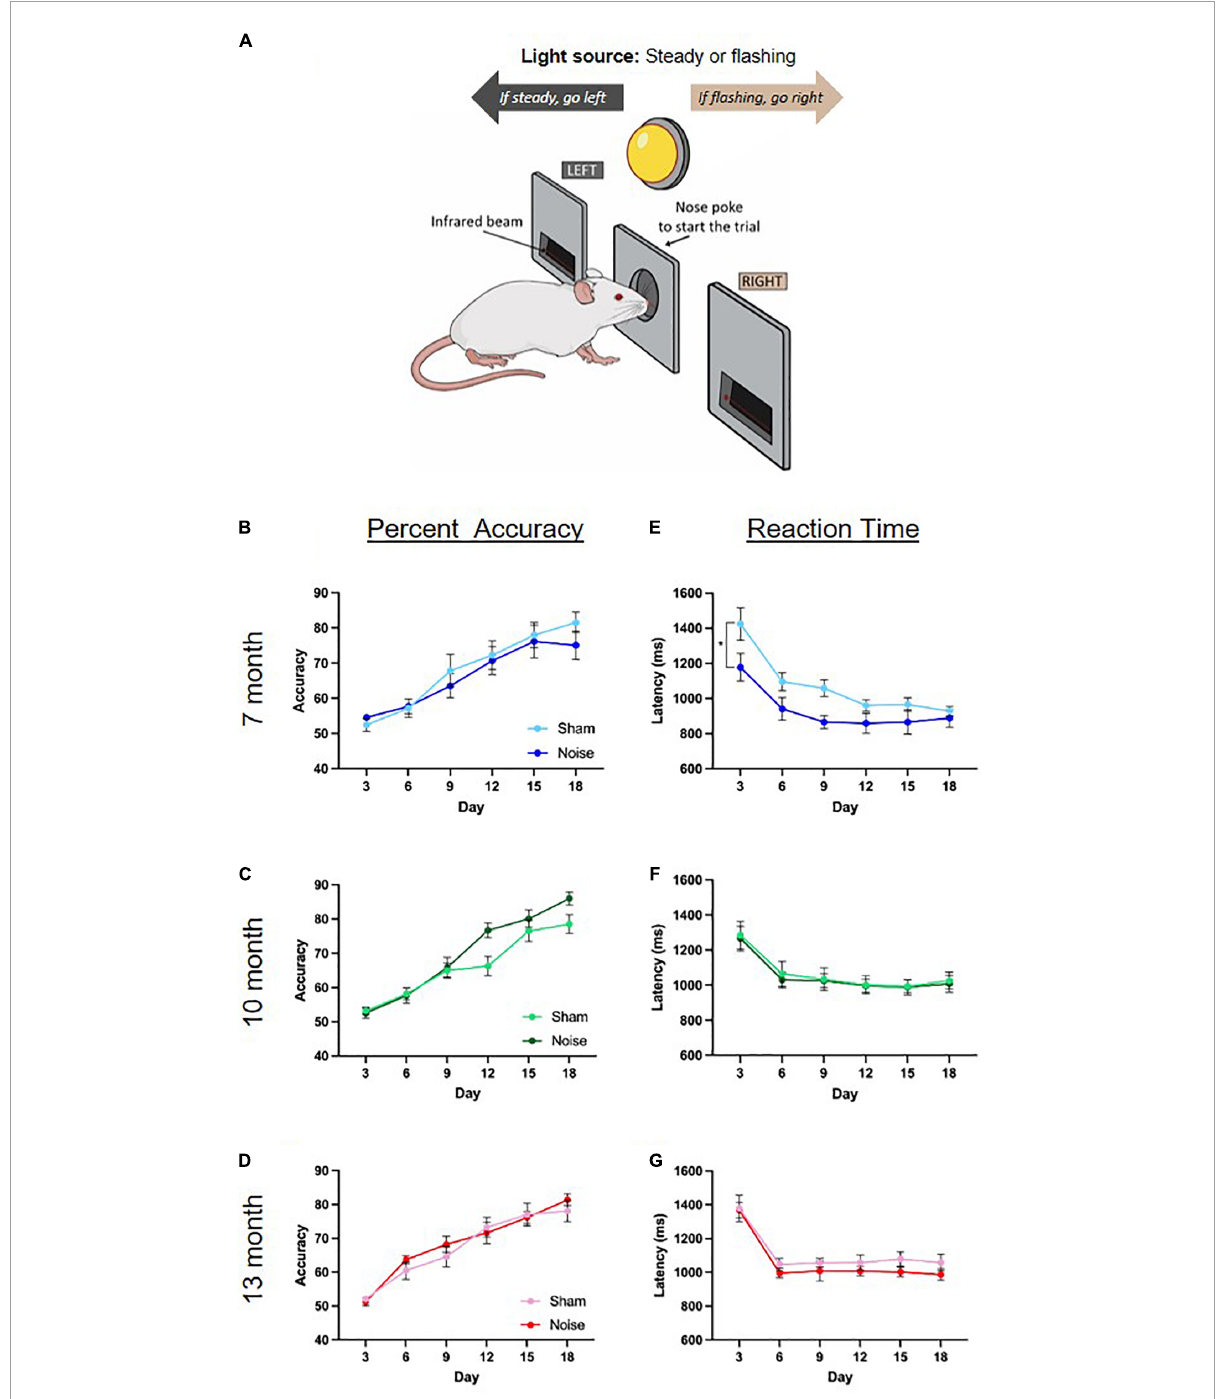
FIGURE4 Noise-exposed rats demonstrated no significant deficits in performance accuracy on the visuomotor associative learning task, but exhibited a faster reaction time in the month post-noise exposure. (A) Rats were trained on an operant conditioning-based visuomotor associative learning task. Following the initiation of a trial caused by a noise poke in the center port, rats learned to access the left feeder trough when the steady light stimulus was presented, and the right feeder trough when the flashing light stimulus was presented. (B–D) Rats at each age demonstrated learning over the 18 days of the task, with no significant differences in percent accuracy between noise- or sham-exposed rats at any age. (E–G) Noise-exposed rats at 7 months of age showed a significantly faster reaction time than their sham-exposed counterparts, an effect that did not persist at 10 or 13 months of age (significant main effect of treatment, * p < 0.05). n = 7-month (Sham: 9 male; Noise: 9 male), 10-month (Sham: 9 male; Noise: 9 male), and 13-month (Sham: 10 male; Noise: 10 male). Data represent group mean ±